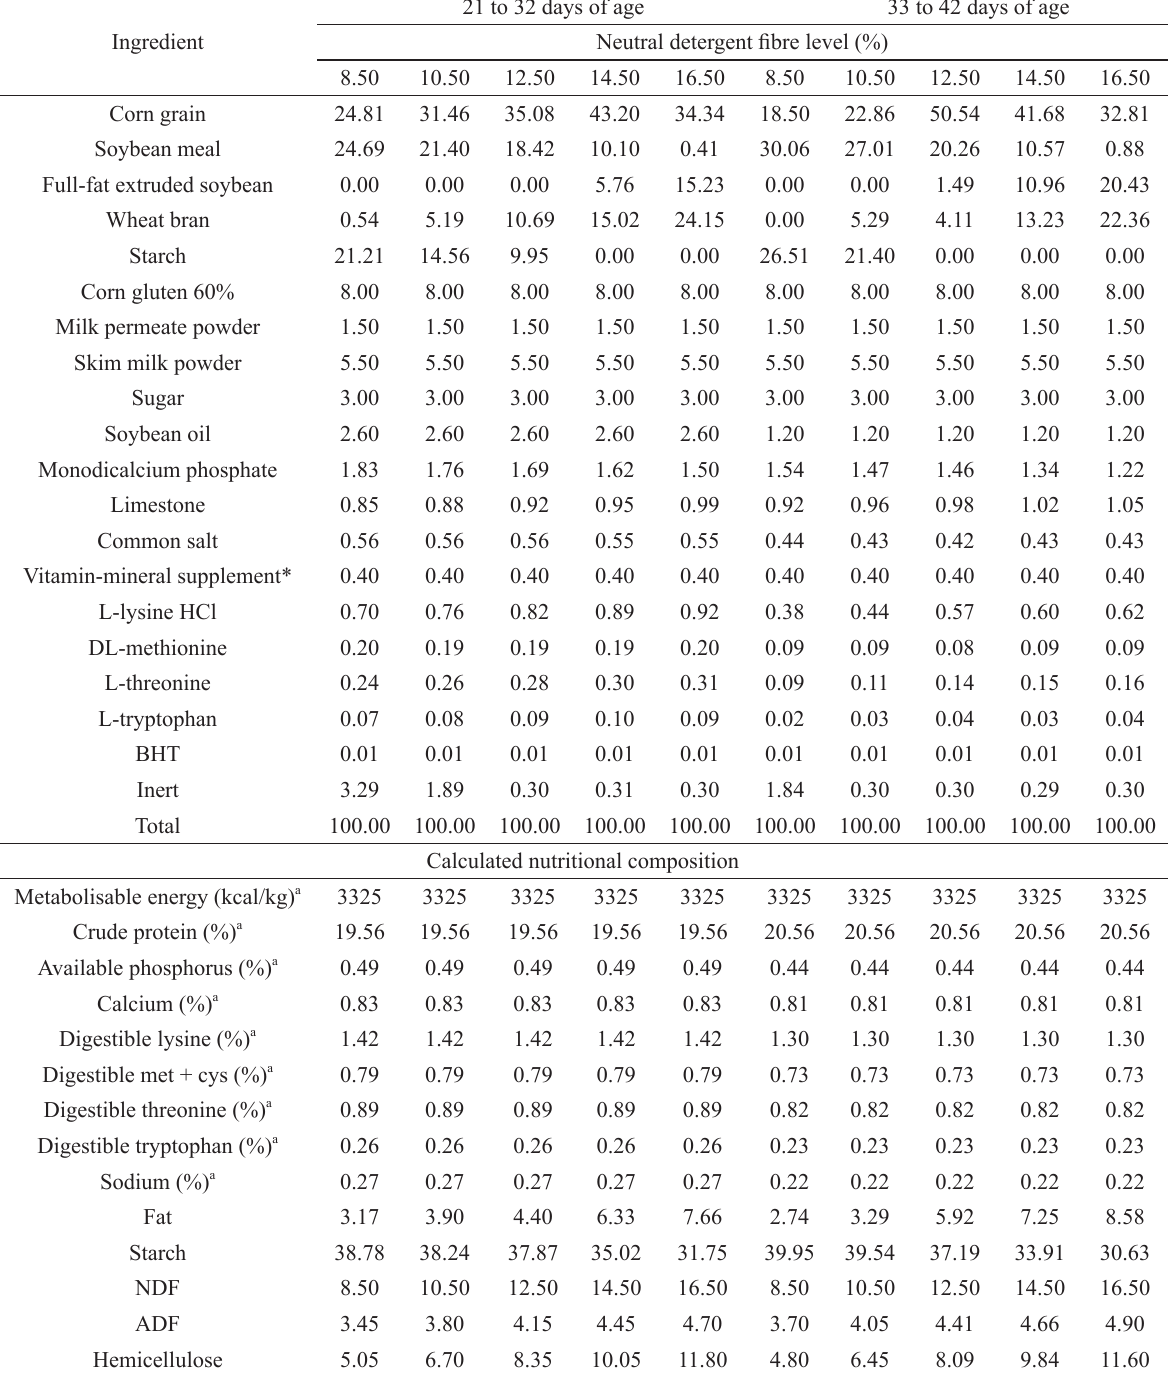
Centesimal and nutritional composition of the experimental diets for piglets in the nursery